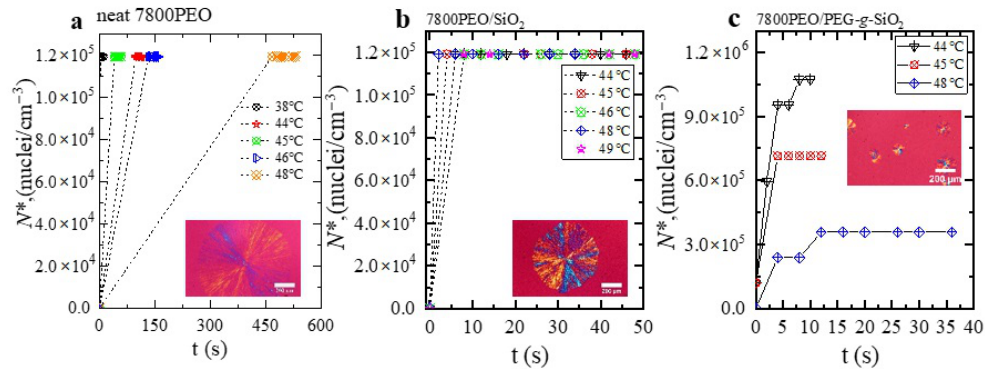
Figure A2. Nucleation density as a function of time at each crystallization temperature ( a ) neat PEO, ( b ) PEO/SiO 2 , ( c ) PEO/PEG-g-SiO 2 . The insets represent the PLOM images of PEO nanocomposites and the molecular weight of matrix PEO is 7800 g/mol.